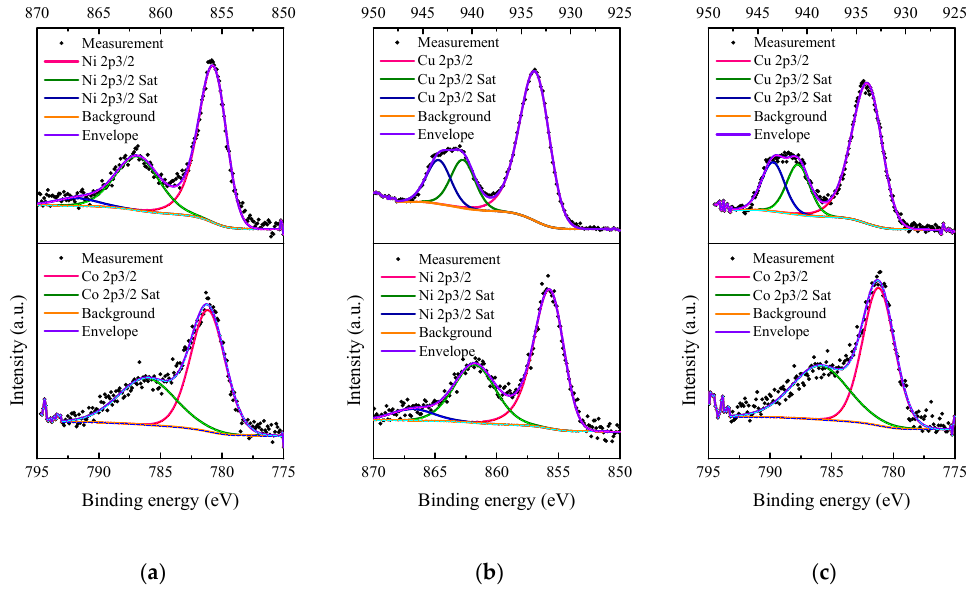
Figure 8. XP spectra of the ( a ) 5Ni5CoAl, ( b ) 5Ni5CuAl and ( c ) 5Co5CuAl catalyst samples.